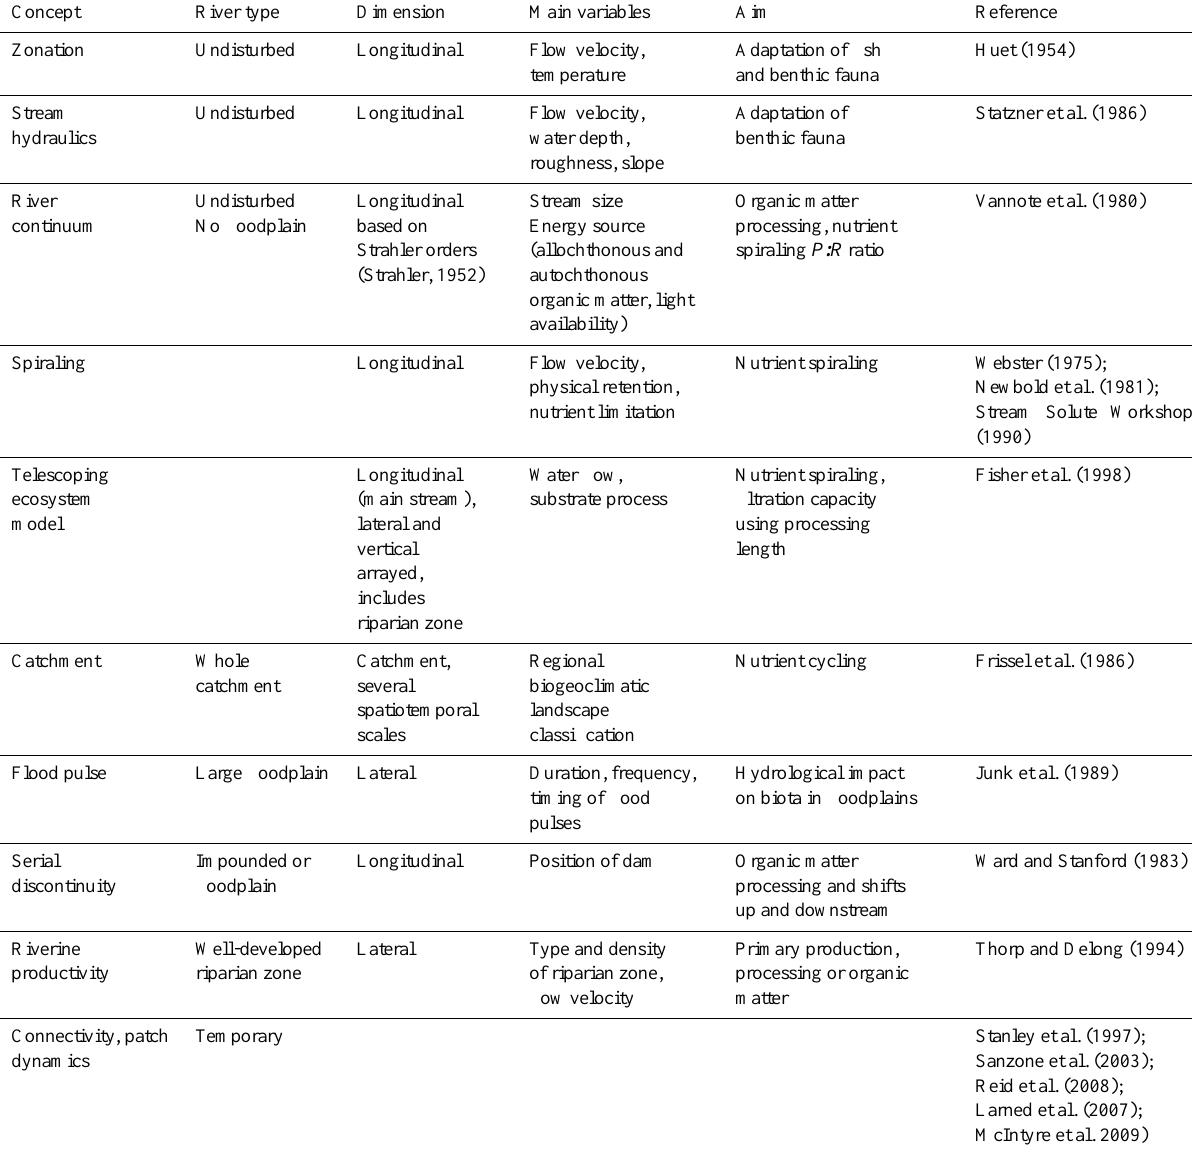
Table 1. River ecology concepts for different types of rivers, and aim and dimensions